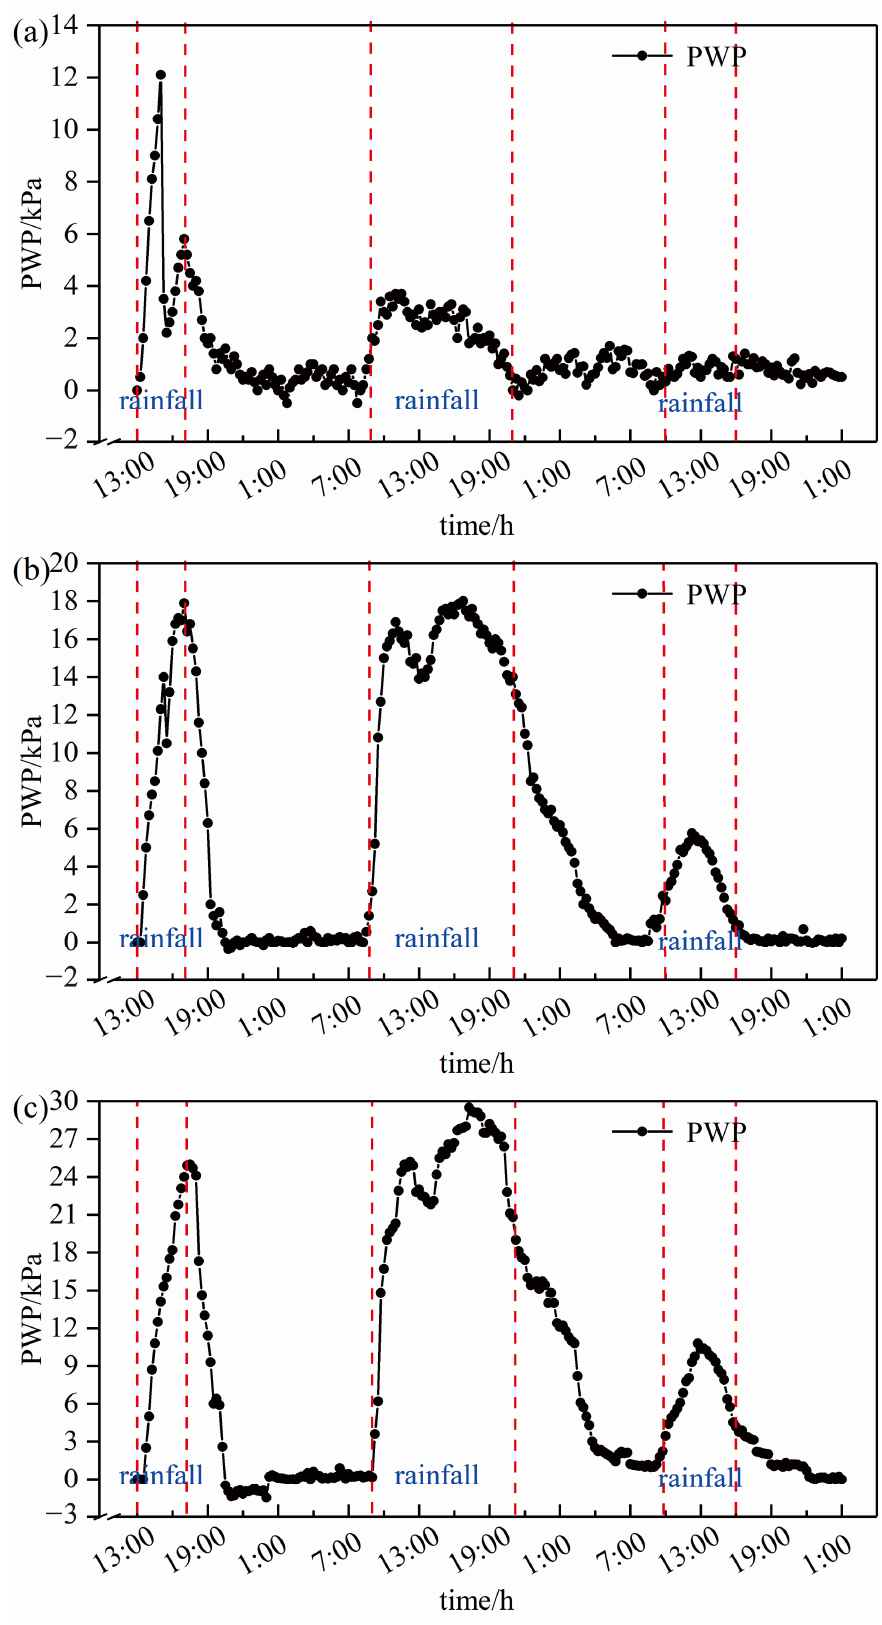
Figure 9. Time-varying curves of pore water pressure at different depths under the second condition: ( a ) 100 cm, ( b ) 200 cm, and ( c ) 300 cm.